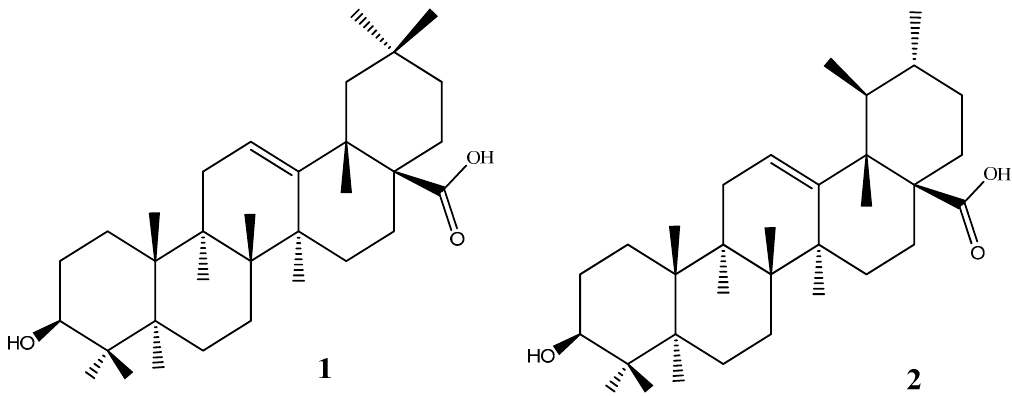
Figure 1. The chemical structure of pentacyclic triterpenes oleanolic ( 1 ) and ursolic ( 2 ) acids.